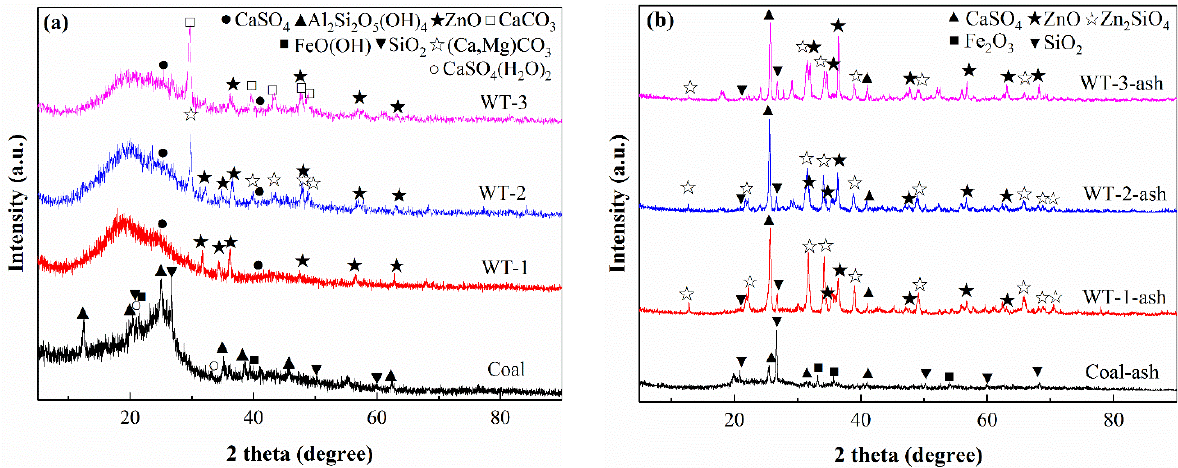
Figure 2. XRD patterns of base coal and three tire wastes ( a ) and their ashes ( b ).